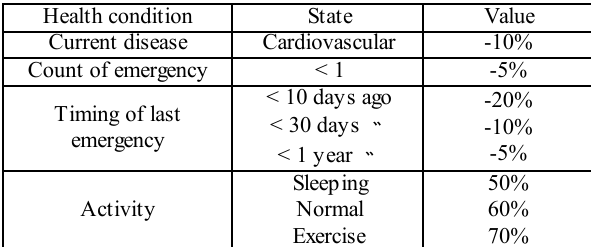
Table 3. The health condition deciding the maximum pulse